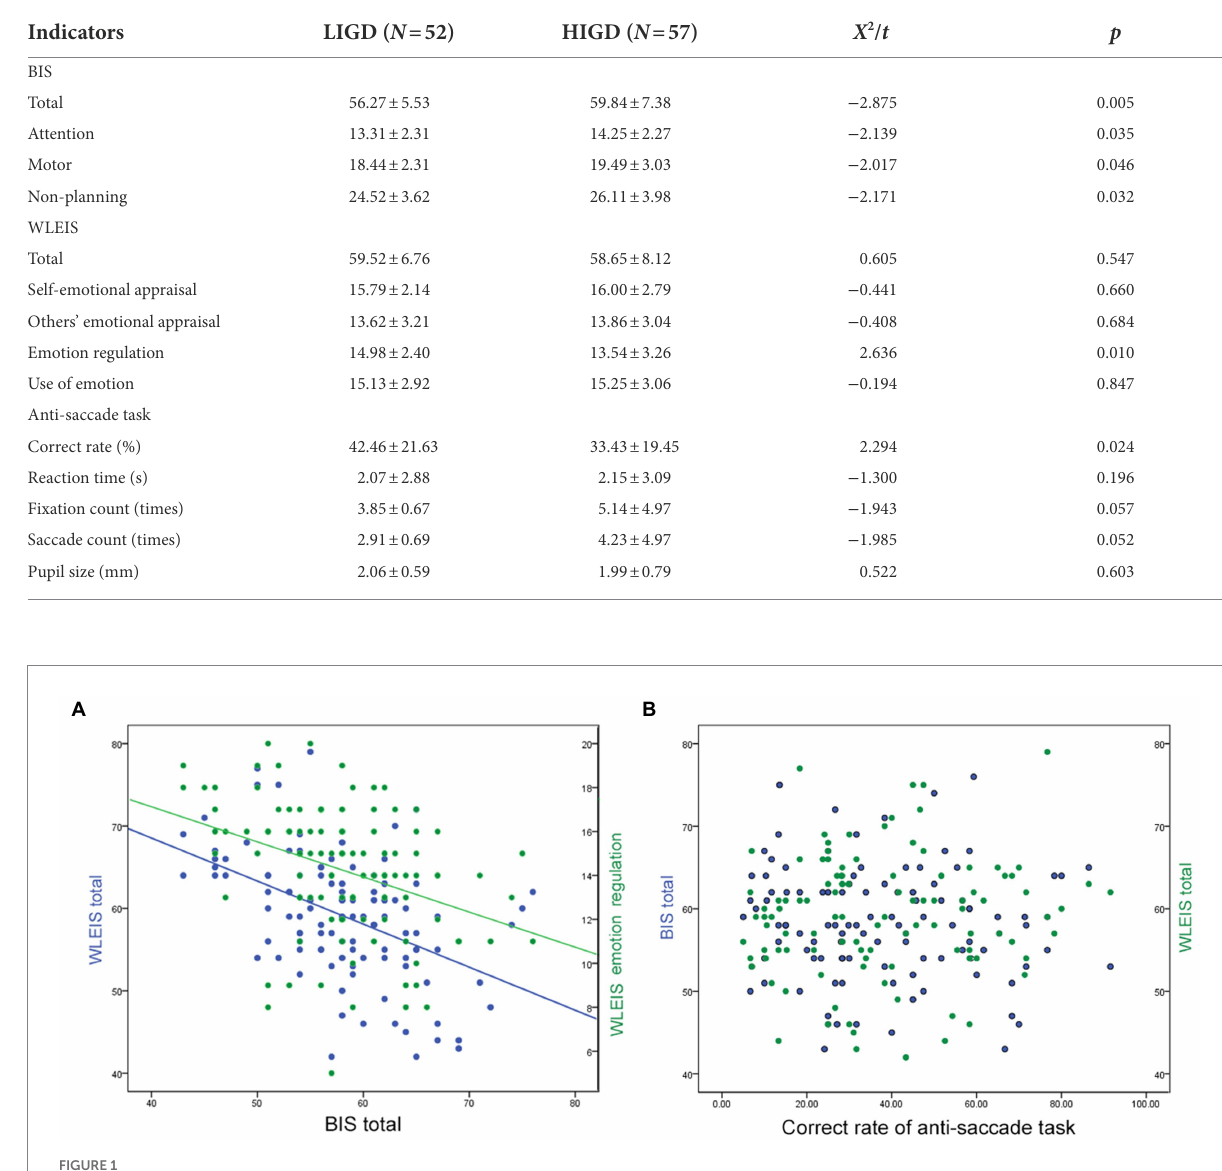
found between LIGD and HIGD groups ( p > 0.050). However, the HIGD group showed significantly longer gaming hours daily than the LIGD group ( t = − 9.562, p < 0.001).